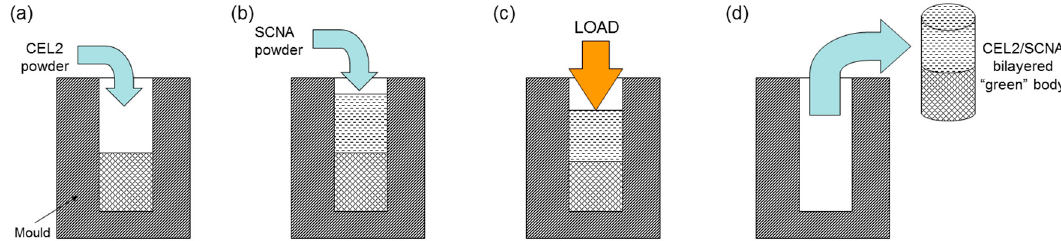
Figure 1. Preparation of the bilayered glass-derived samples for potential use in dental implantology: casting of ( a ) CEL2 powders; and ( b ) SCNA powders in the mould; ( c ) 1-D pressing; and ( d ) extraction from the mould.